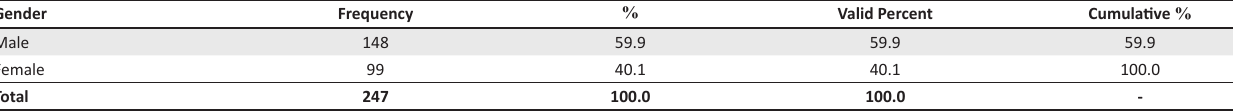
TABLE 1: The statistics on gender: Male versus female respondents.